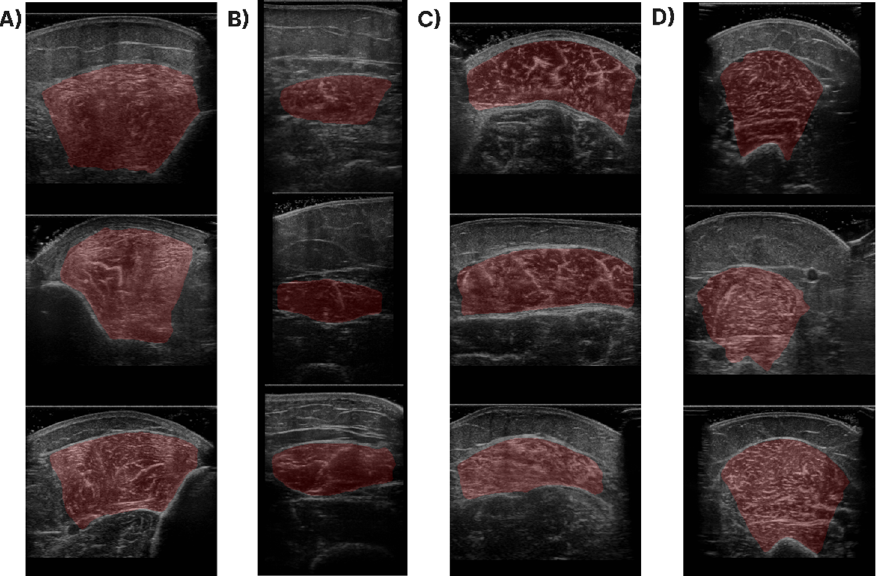
Figure 8. Qualitative results of the CSA segmentation for samples of the ( A ) T.A., ( B ) R.F., ( C ) GCM, and ( D ) B.B. The red areas are the predicted masks superimposed onto the input image.